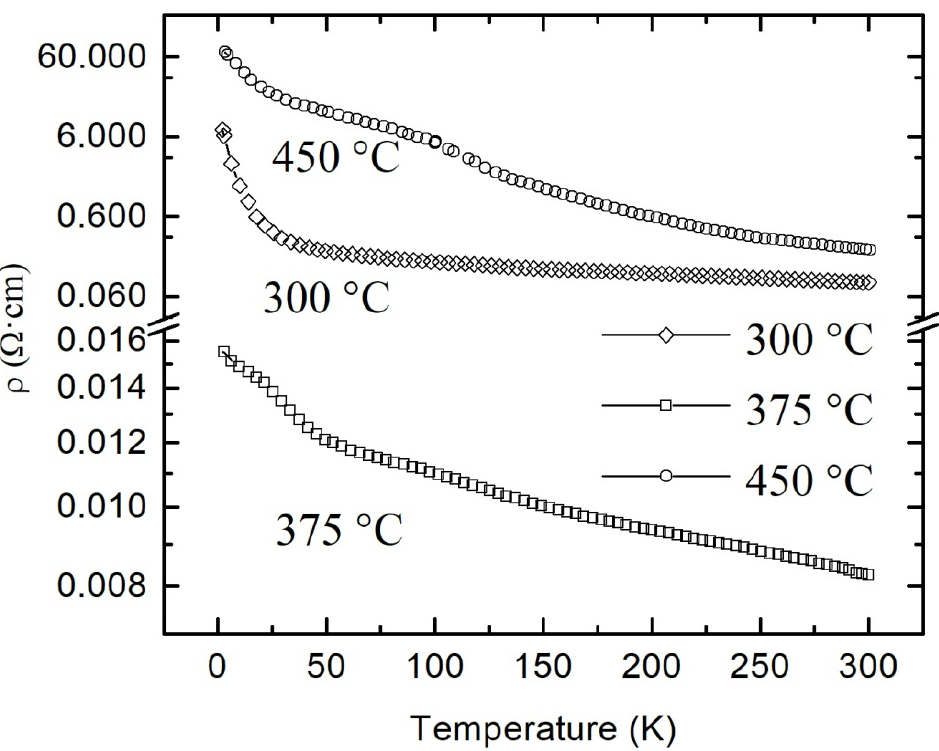
Figure 4. Temperature dependences of the resistivity of polycrystalline SnO 2 − δ films deposited by reactive magnetron sputtering of tin on glass with the following annealing in air at different temperatures.